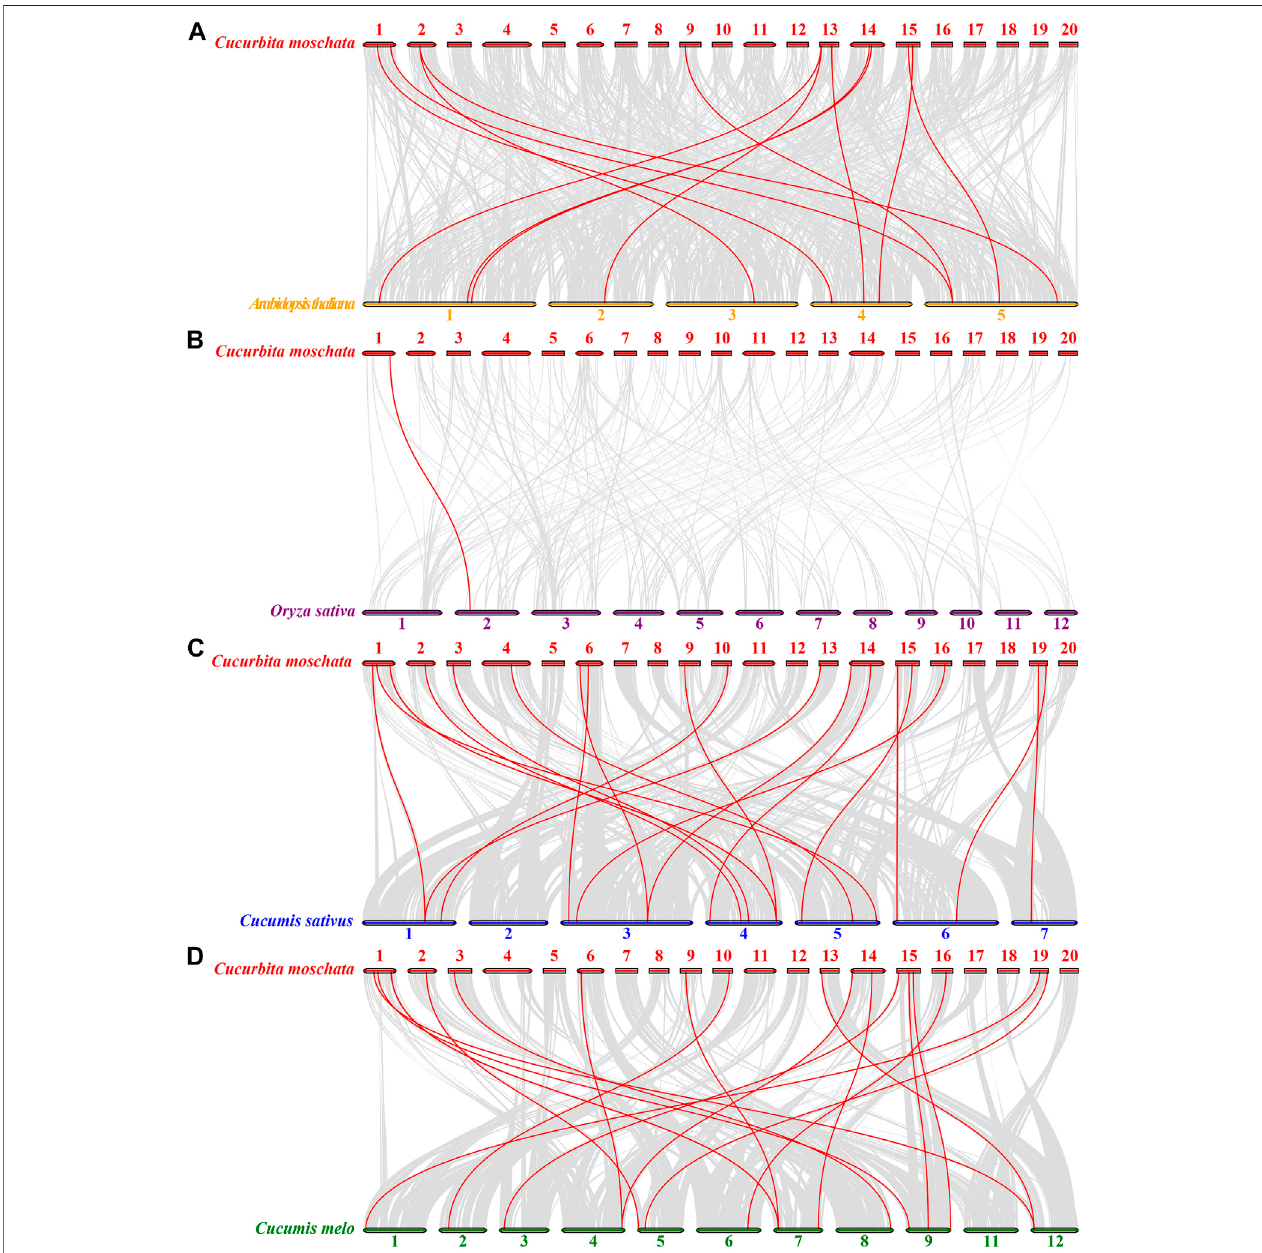
FIGURE 6 | Synteny analyses of HSP20 genes between Cucurbita moschata and four other representative plant species ( Arabidopsis thaliana , Oryza sativa , Cucumissativu and Cucumismelo ).( A ) C.moschata and A.thaliana .( B ) C.moschata and O.sativa .( C ) C.moschata and Cucumissativu .( D ) C.moschata and Cucumis melo .Graylinesindicatesigni fi cantlycollinearblockswithinandamongplantgenomes,whileredlineshighlightsyntenic HSP20 genepairs.Thechromosomenumberis indicated at the top of each chromosome.